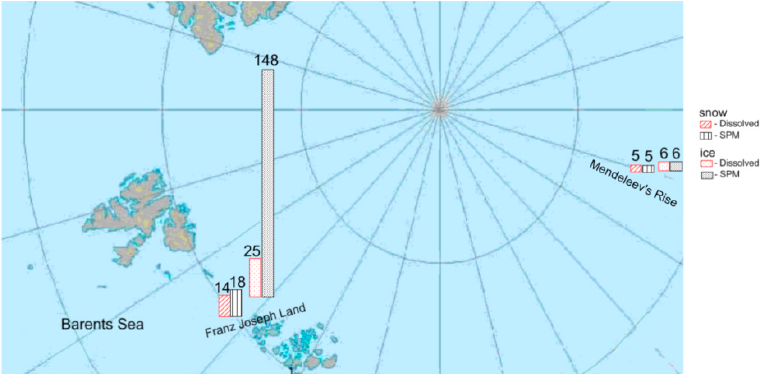
Figure 1. Distribution of AHC concentrations in snow and upper layer of ice in the areas of the Franz Victoria Trough and the Mendeleev Rise.